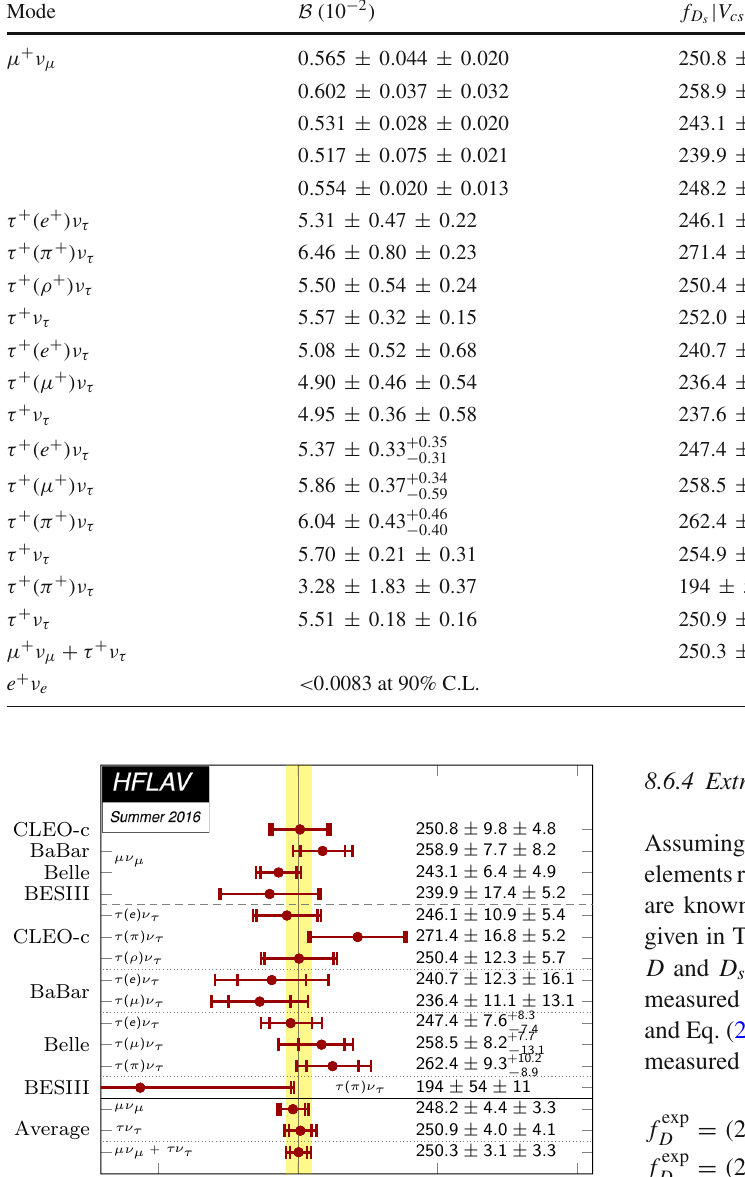
pion and neutrinos [6]. CLEO-c and BaBar include statistical uncer- | V | cs s ). We have s